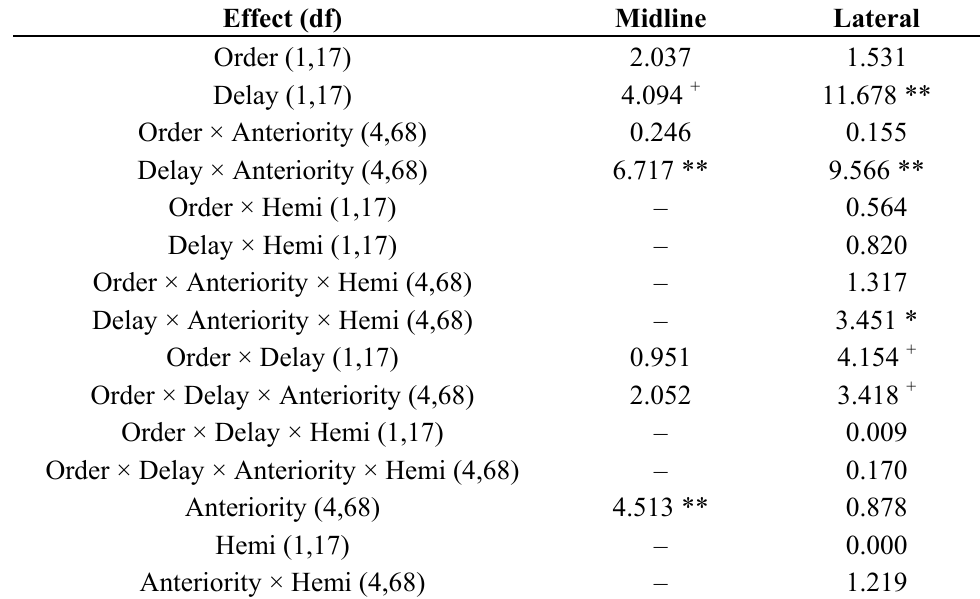
Table 2. Results from ANOVA ( F -values) on the mean amplitudes in the 600–900-ms interval from the onset of the pre-delay